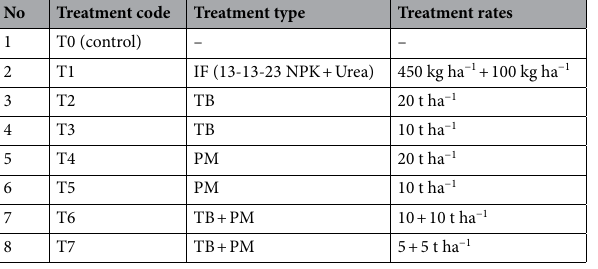
Table 6. Experimental treatments with organic manures and inorganic fertilzer. TB Tithonia diversifolia fresh biomass, PM poultry manure, IF inorganic